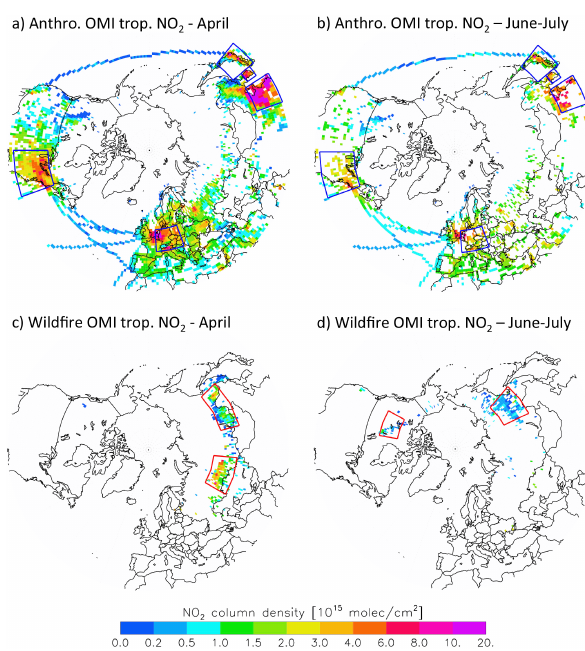
Figure 13. OMI NO 2 filtered for dominant anthropogenic emis- sions (a, b) and fire emissions (c, d) . Boxes indicate the regions for which biases have been calculated in Fig. 14. Panels (a) and (c) show April, panels (b) and (d) show June–July. also lead to model errors in NO y partitioning (Browne et al.,